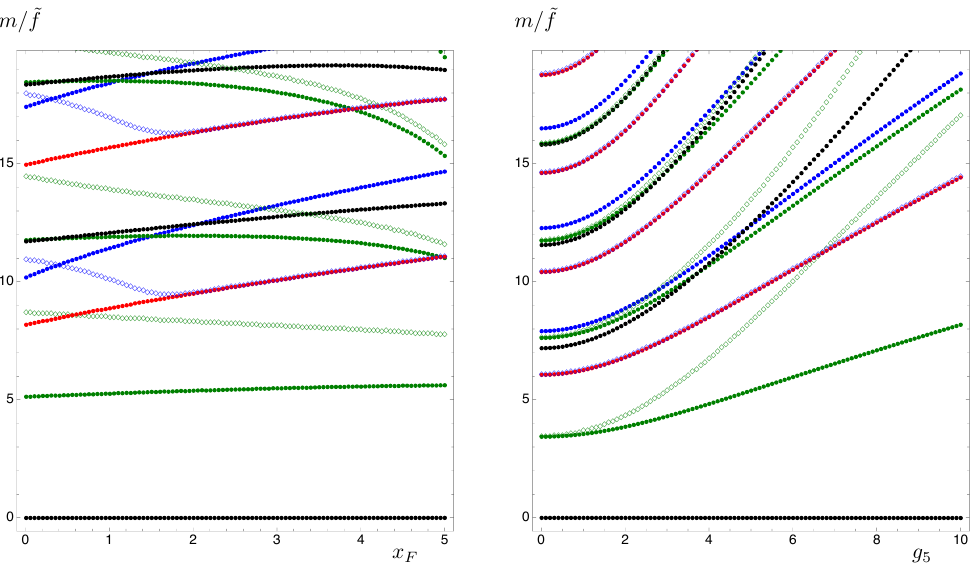
Figure 11 . Model I. The left panel shows the spectrum as a function of x F for ∆ = 3 , g 5 = 5 , ρ 1 = − 7 , ρ 2 = 8 . The right panel shows the spectrum as a function of g 5 for x F = 2 , ∆ = 3 , ρ 1 = − 7 , ρ 2 = 10 . Both panels are normalized to the decay constant coding for the spectrum is: singlet scalar (blue), non-singlet scalar (blue diamonds), tensor (red), pseudoscalar (black), vector (green), axial-vector (green diamonds). Since ∆ > 2 , there is also a massless dilaton in the spectrum, as can be seen from figure 10; due to the numerical resolution deployed only the Goldstone is shown in the present two